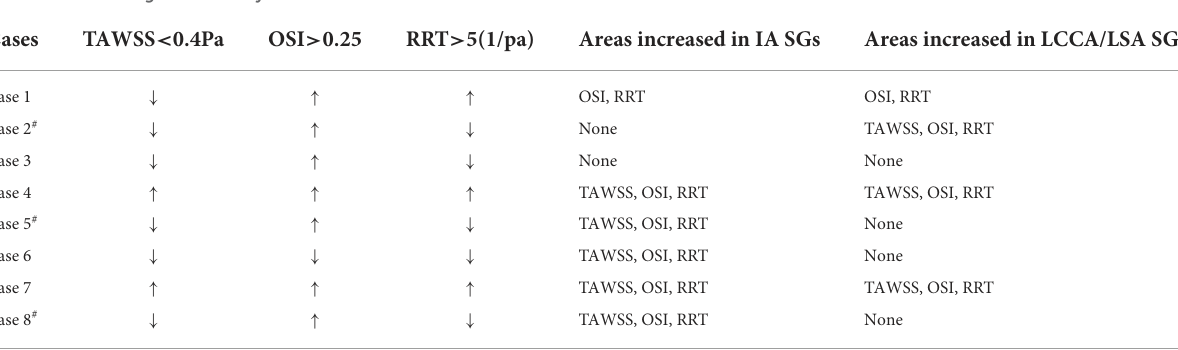
TABLE 3 Area changes of hemodynamic